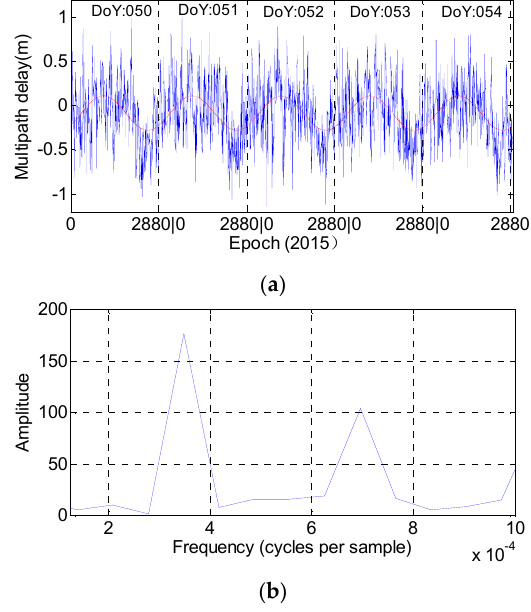
Figure 12. The fitted curve ( red line ) and magnitude spectrum ( b ) of C04 at station GMSD. The observation sampling rate is 30 s. ( a ) Represent the multipath delay during the five consecutive days.